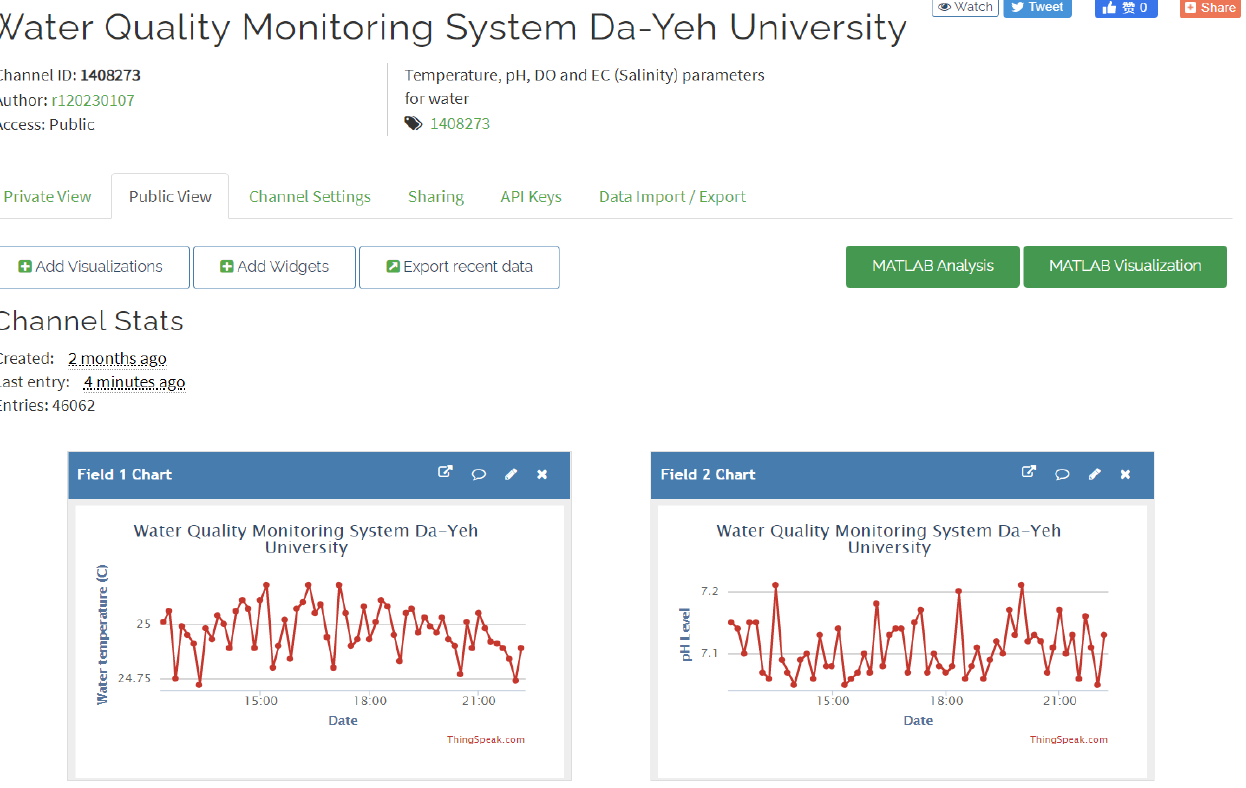
Figure 4. Snapshot of ThingSpeak IoT for water quality monitoring system.